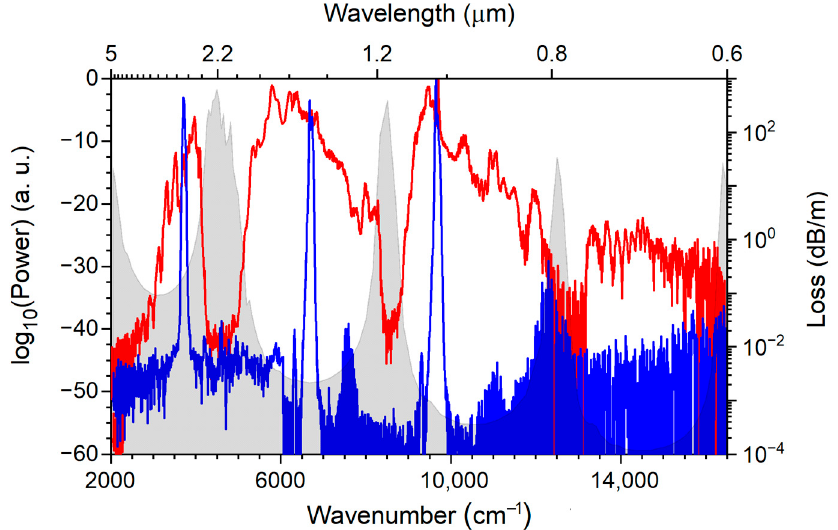
Figure 7. The spectra measured at the output of the HCF for pump pulse duration of 12 ps (blue curve) and 1 ps (red curve). The coupled pump pulse energy was 50 μ J, the pressure of D 2 was 30 atm, and thefiber length was 2.9 m. The optical loss spectrum of the HCF is also shown (grey filled curve). filled